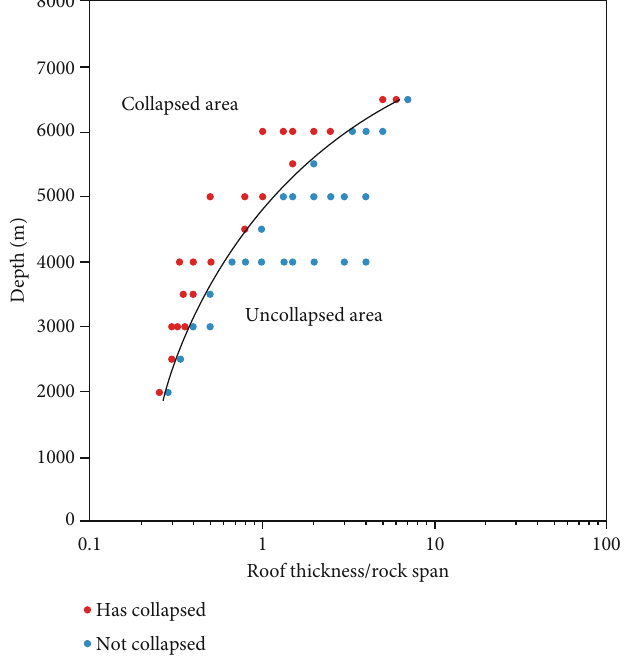
Figure 10: Judgment chart for cave